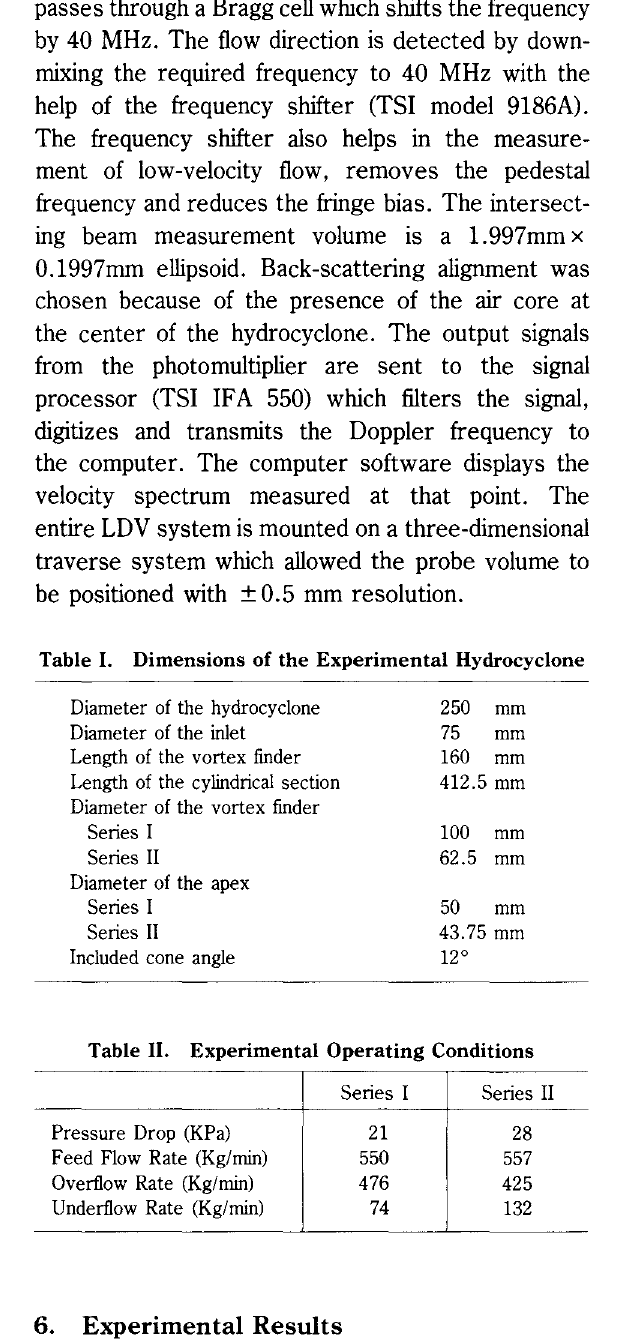
Table II. Experimental Operating